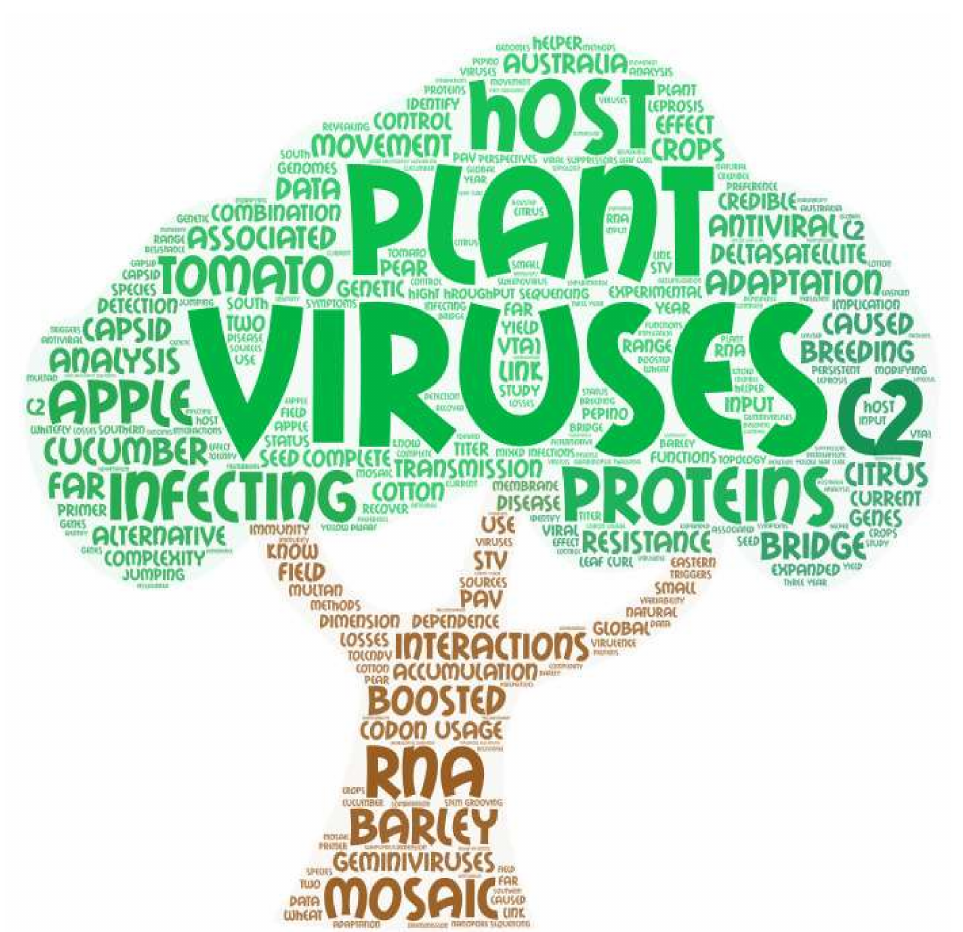
Figure 1. A word cloud created from the titles of every article published in this Special